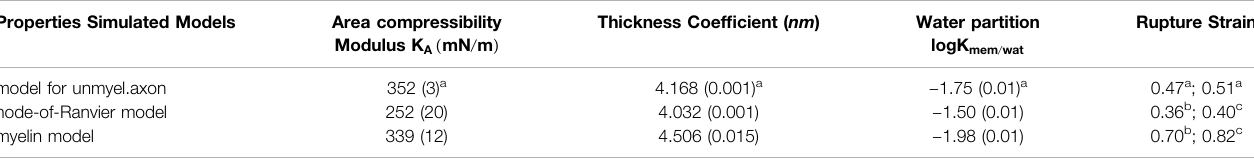
TABLE 2 | Bilayers structural and mechanical properties. In parenthesis standard error. Properties Simulated Models